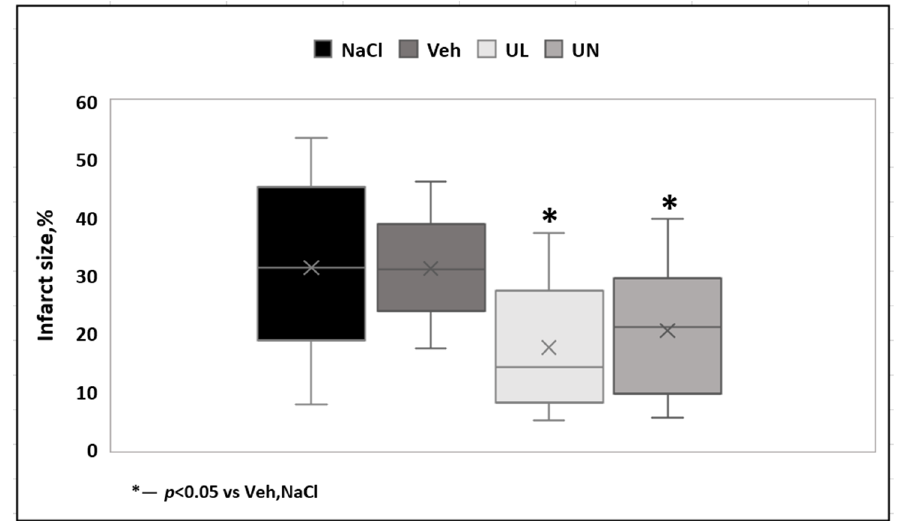
Figure 3. Brain infarct size (% to ipsilatheral hemisphere) 24 hours after middle cerebral artery occlusion. Groups: NaCL–MCAO + NaCL; Veh–MCAO + Vehicle; UL–MCAO + Ubiquinol; UN–MCAO + Ubiquinone.